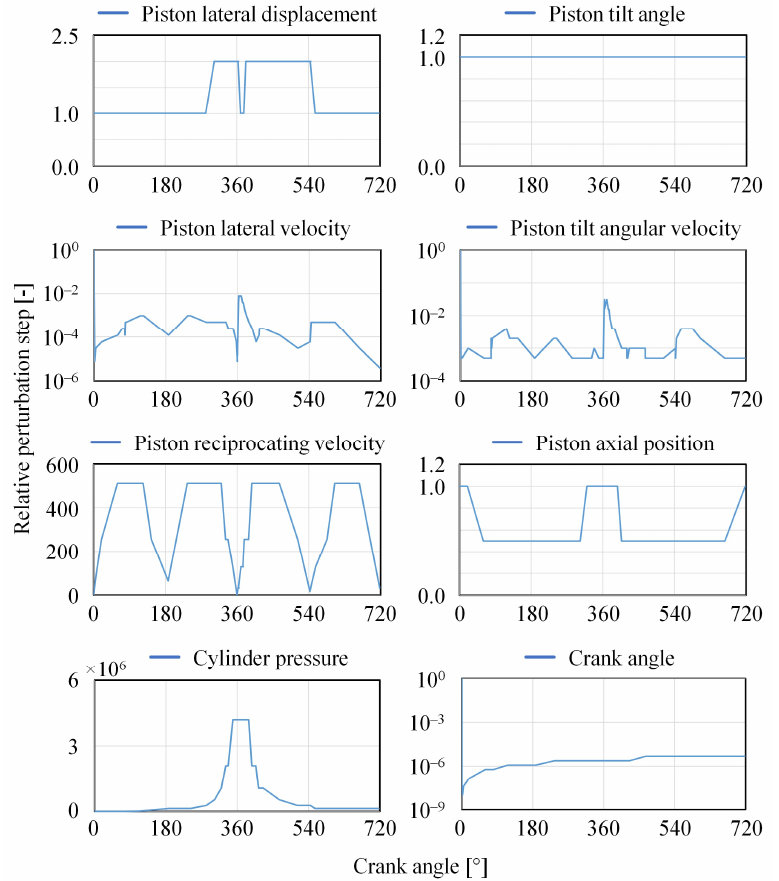
Figure 4. Relative perturbation steps of subroutine’s measurements not related to deformation. The values are plotted depending on the crankshaft angular position.